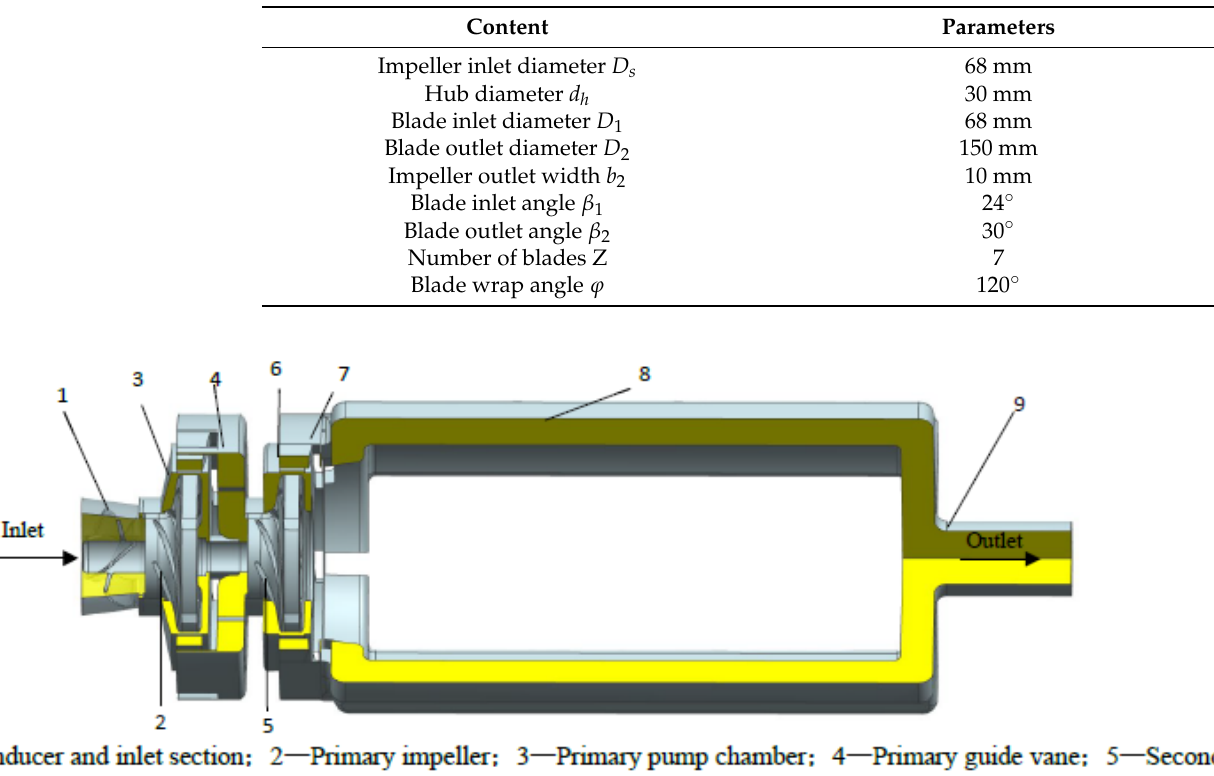
Figure 1. Water body assembly drawing of the LNG submersible pump.